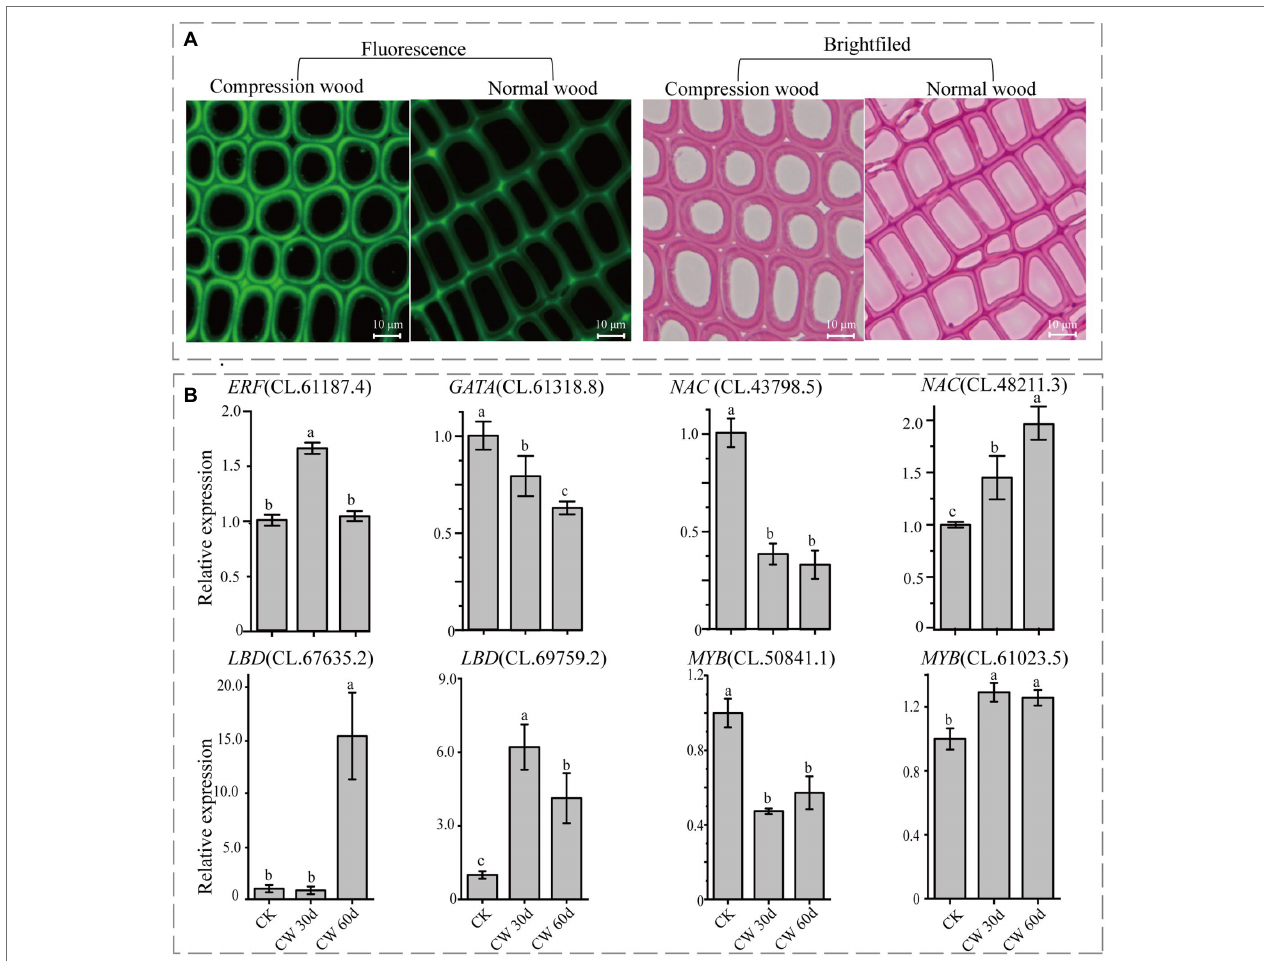
FIGURE 7 | Changes of the cell wall structure and the relative transcriptional abundance of identified transcription factors. (A) Observation of compression wood and normal wood (30 days) by safranine staining and fluorescence microscopy. (B) The relative transcriptional abundance of eight TFs in normal wood (CK) and compression wood (CW). Values followed by different lower-case letters are significantly different according to Duncan test ( p <